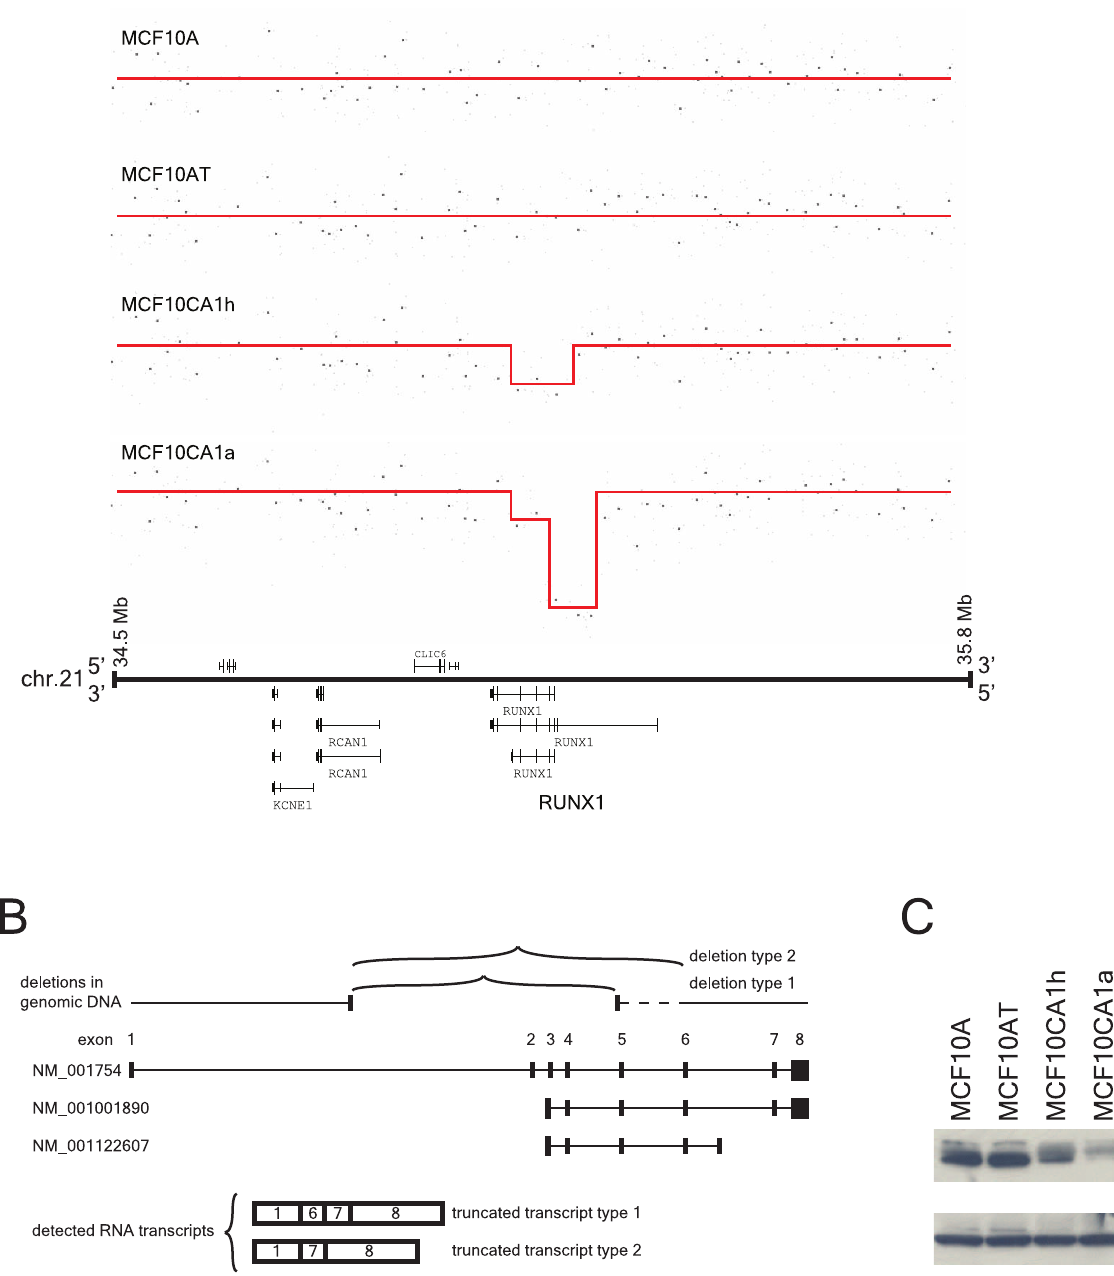
Figure 2. Intragenic RUNX1 deletions in the MCF10A series of cell lines. Figure 2A illustrates intragenic DNA deletion and partial deletion in MCF10CA1a and MCF10CA1h, respectively. The deletions span the promoter regions of two of the transcripts. Note that the transcripts are oriented from right to left in this figure. Figure 2B summarizes altered transcripts detected in MCF10CA1a cells due to indicated genomic deletions. Deletion structure is illustrated here based on the data shown in Figure 2A. Three alternative transcripts of the RUNX1 gene are shown here. Truncated transcripts involving removal of exons 2–5 (truncated type 1) or exons 2–6 (truncated type 2). Figure 2C shows Western blot analysis of the RUNX1 protein in the MCF10A series of cell lines. RUNX1 protein expression was analyzed by Western blot using anti-RUNX1 antibody. The b -actin staining shows a similar level of protein loading in all lanes. Note the dramatic reduction of the RUNX1 protein in MCF10CA1a cells. MCF10CA1h cells show a reduced level of RUNX1 protein.